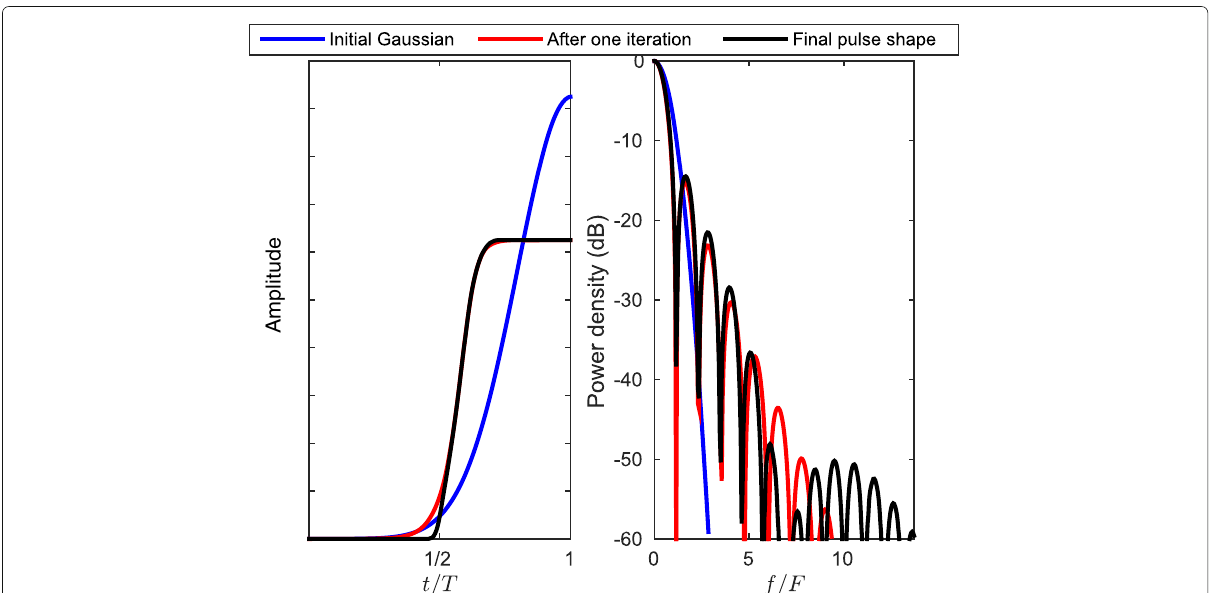
Fig. 4 Time and frequency impulse responses for the initial Gaussian pulse, pulse after the first iteration, and the final pulse